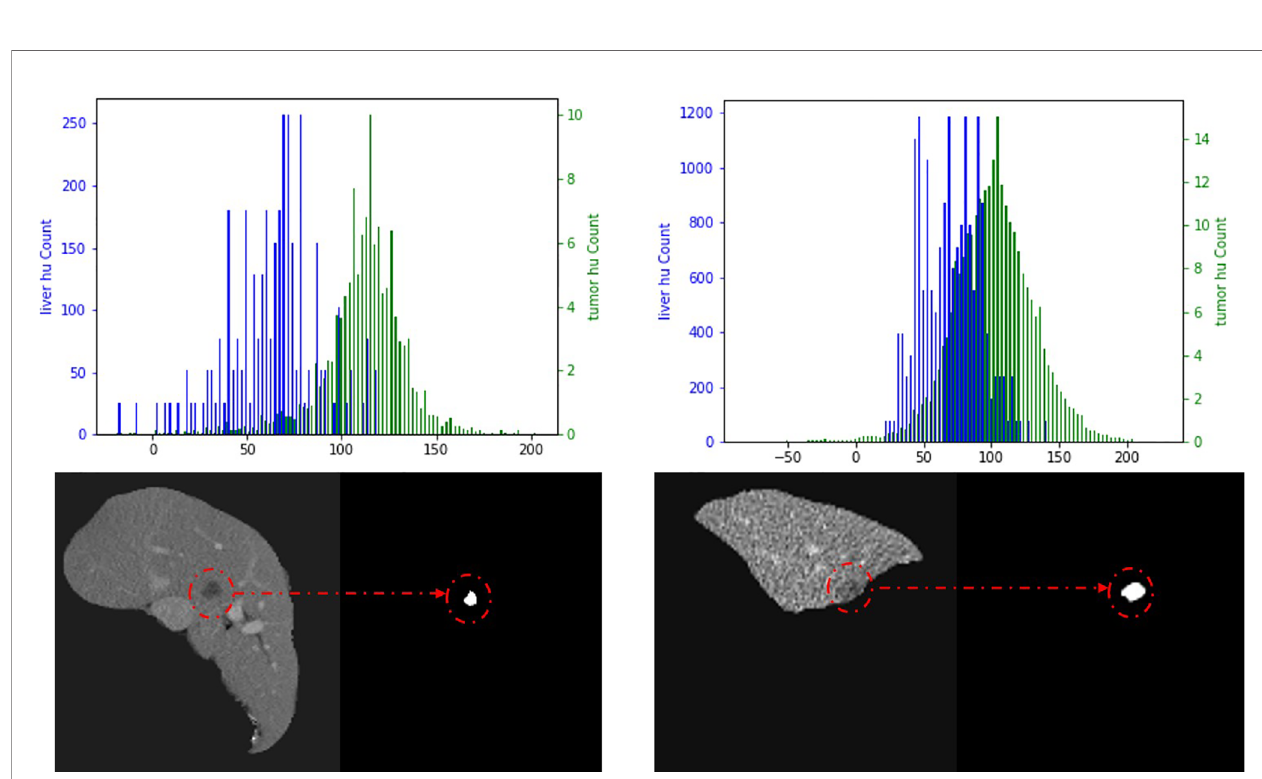
FIGURE 4 | The left panel is a high-contrast section and the right panel is a low-contrast section. Blue is the liver HU value and green is the tumor HU